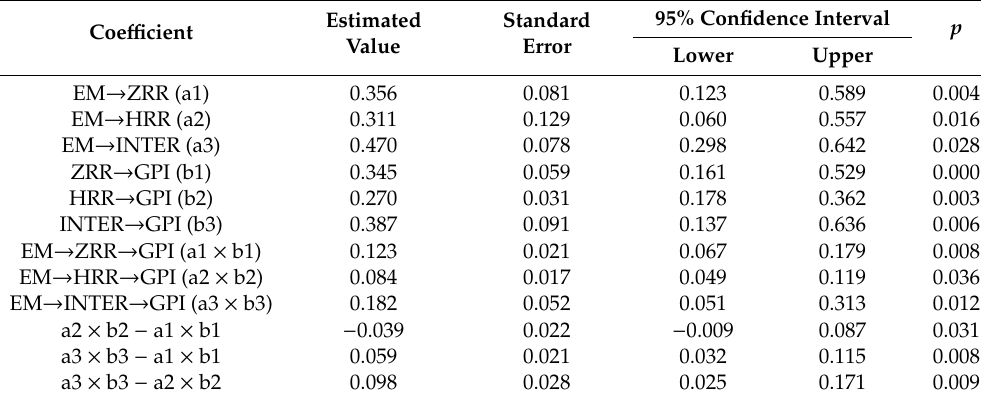
Table 3. Results of bootstrapping